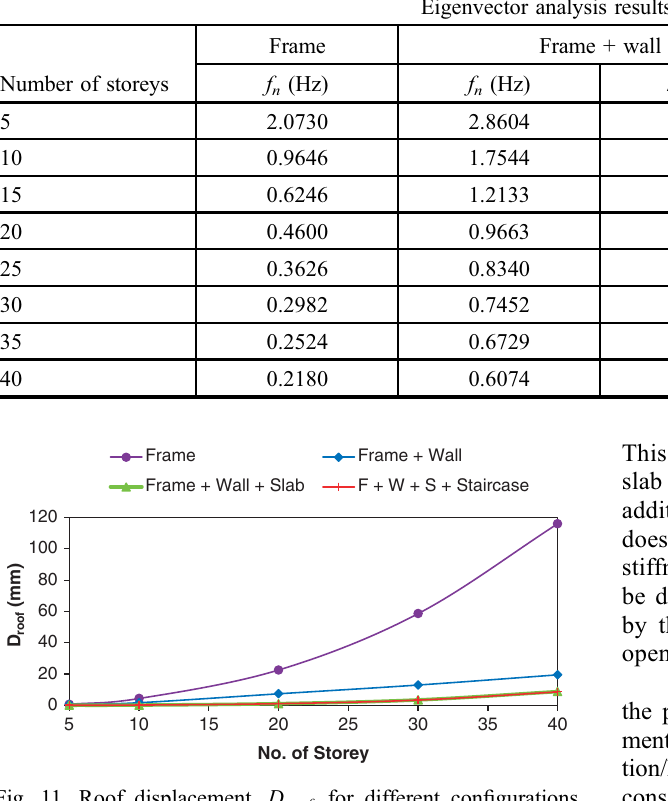
40-storey building) which are also mentioned in Table 4.